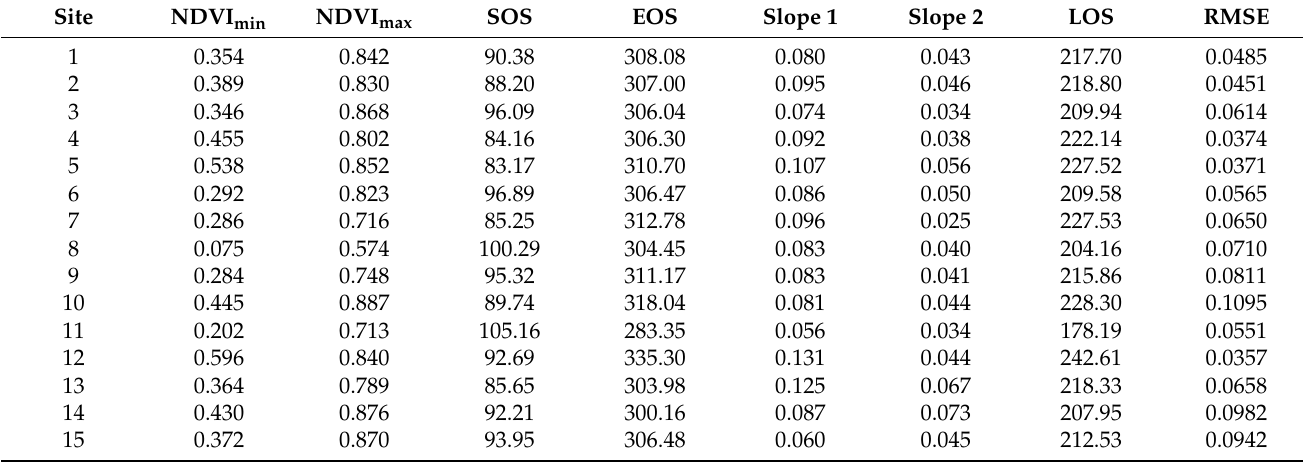
Table 2. Phenology parameters extracted using the double logistic method for combing time series data between 2017 and 2020 for each forest site using MODIS NDVI data. Site numbering from 1 to 15 corresponds to Figure 1 description of each World Heritage